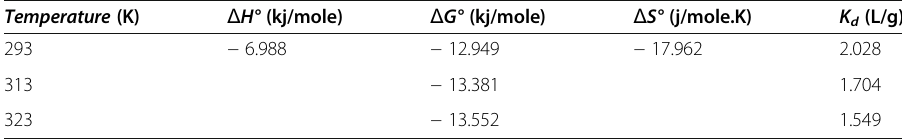
Table 5 Thermodynamic parameters of the nickel adsorption by BF